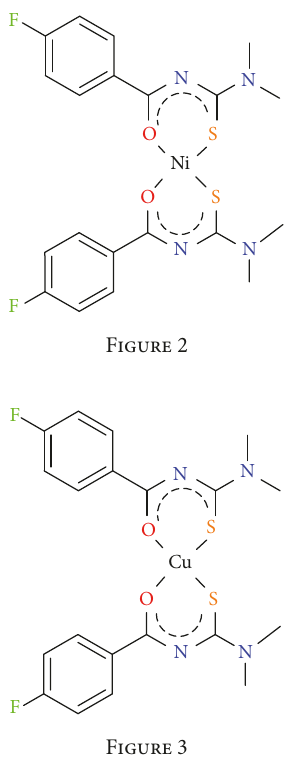
Bis(N,N-dimethyl-N 󸀠 -4-fluorobenzoylthioureato) Nickel(II) ) (See Figure 2) . Color: Purple. Yield: 86 %. M.p.: 257- (NiL 2 ∘ C. Anal. calcd. for C 20 H 20 F 2 N 4 NiO 2 S 2 (509.2 g/mol): C, 258 47.17; H, 3.96; N, 11.00. Found: C, 47.10; H, 3.87; N, 11.01%. FT-IR (KBr, ] , cm −1 ): ] (CH) 2929, 2853 (vw); ] (CN) 1602 (w); ] (C-O), 1495 (vs); ] (C-F), 760 (w). 1 H NMR (300 MHz, CDCl 3 , 𝛿 , ppm): 8.13 (m, 4H, Ar-H), 7.06 (m, 4H, Ar-H), 3.42 (s, 6H, N-CH 3 ), 3.32 (s, 6H, N-CH 3 ). Bis(N,N-dimethyl-N 󸀠 -4-fluorobenzoylthioureato) Copper(II) ) (See Figure 3) . Color: Green. Yield: 71 %. M.p.: (CuL 2 209-210 ∘ C. Anal. calcd. for C 20 H 20 CuF 2 N 4 O 2 S 2 (514.1